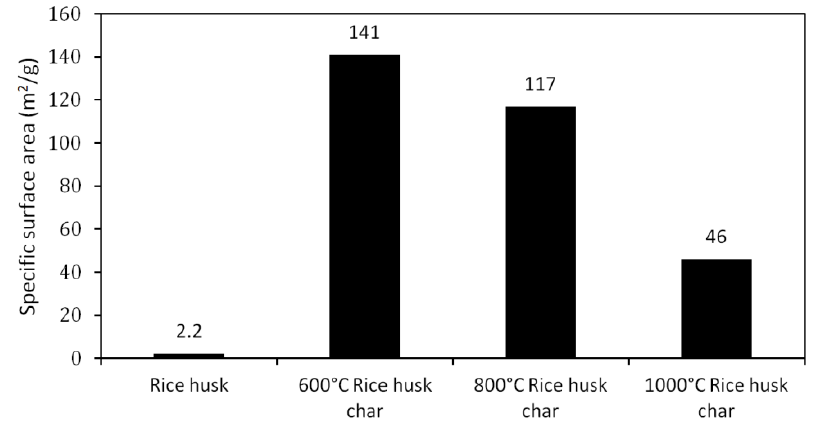
Figure 5. BET specific surface area values of rice husk and rice husk